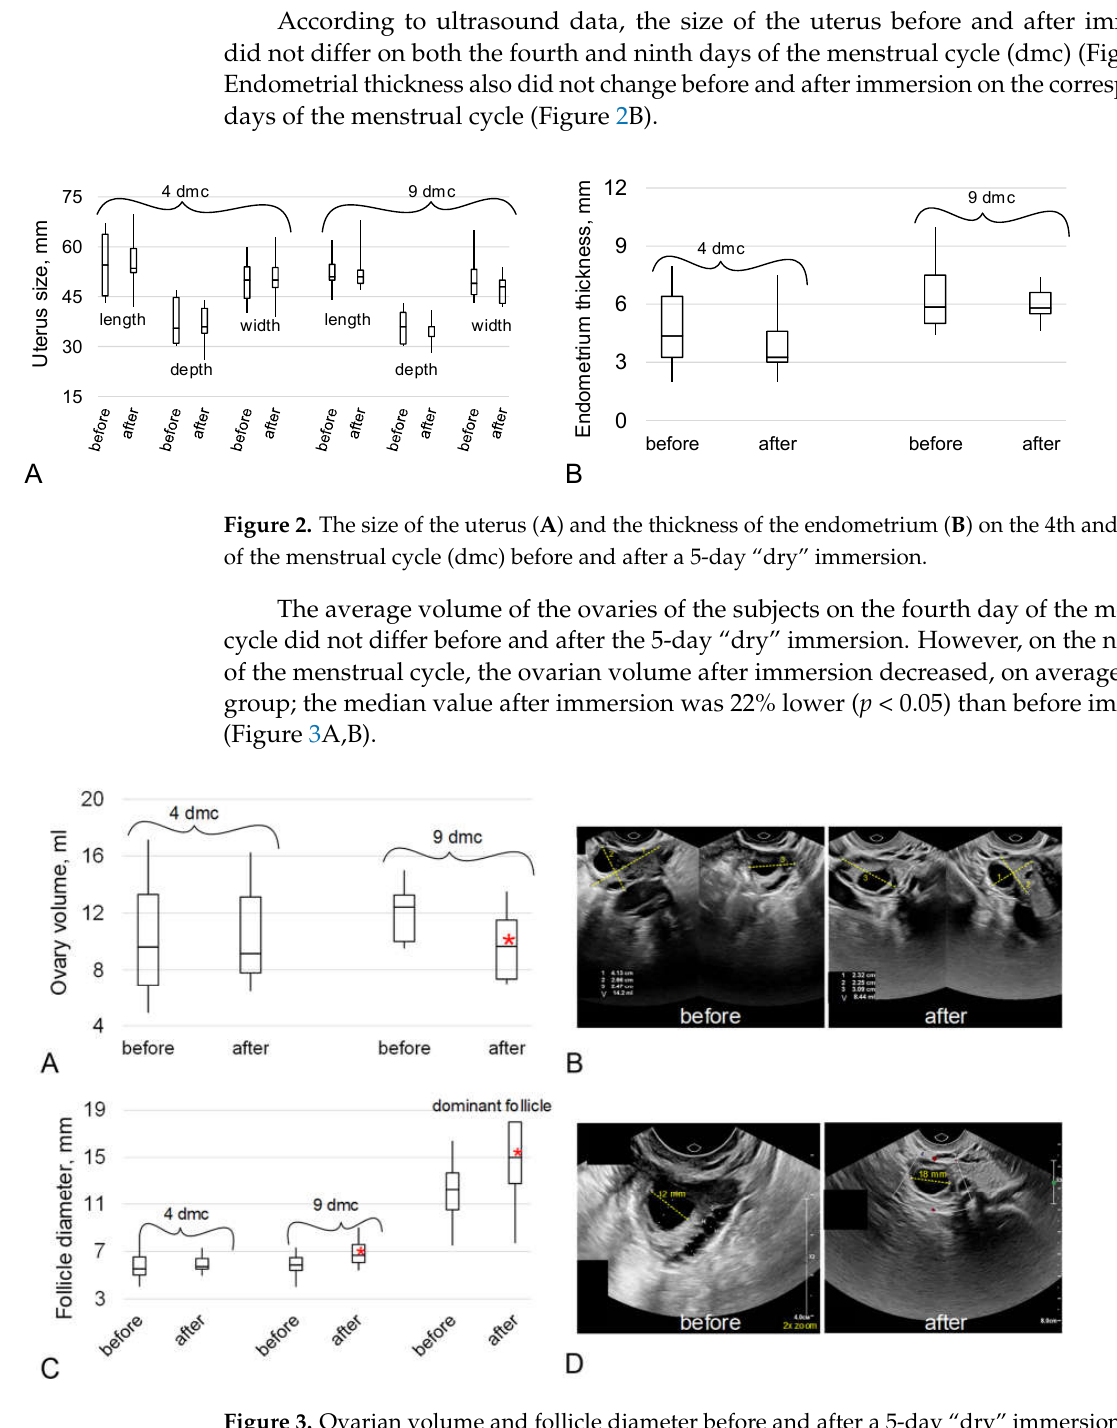
Figure 3. Ovarian volume and follicle diameter before and after a 5-day “dry” immersion on days 4 and 9 of the menstrual cycle. ( A ) Average ovarian volume for the group. ( B ) An example of an ultrasound picture: right ovary, 9th day of the menstrual cycle of the same subject before and after immersion—ovary volume decreased from 14 mL to 8.4 mL. Yellow dotted lines show the ovary sizes in the three dimensions, which are indicated by numbers 1, 2, 3 in the image ( C ) Average follicle diameter for the group. ( D ) An example of an ultrasound picture: 9th day of the menstrual cycle of the same subject before and after immersion—dominant follicle diameter increased from 12 mm to 18 mm. Yellow dotted lines mark the size of the dominant follicle (a 2x zoom is used in the “before” picture). * p < 0.05 in comparison to “before” of the same day of the menstrual cycle